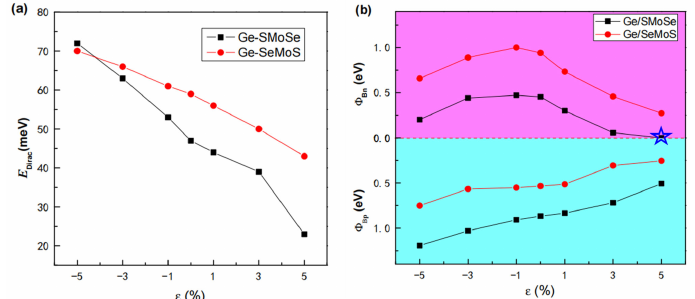
Figure 7. ( a ) The Dirac gaps E Dirac at K point for Ge/SMoSe and Ge/SeMoS heterostructures as a function of strain; ( b ) The SBHs ( Φ Bn and Φ Bp ) of Ge/SMoSe and Ge/SeMoS heterostructures as a function of strain.